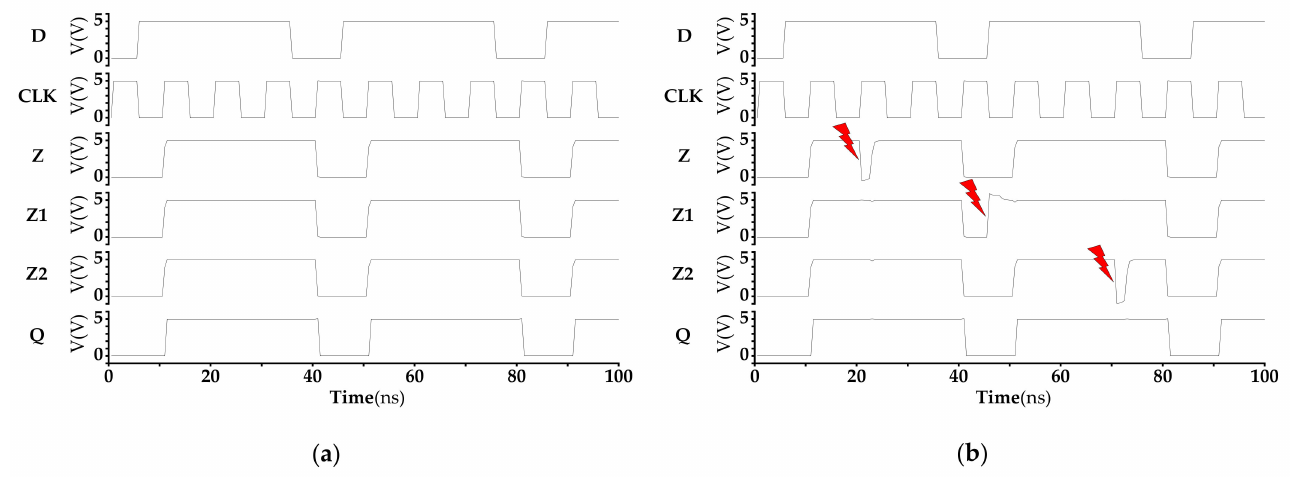
Figure 7. TMR-DFF: ( a ) simulation waveform of TMR-DFF without SETs; ( b ) simulation waveform of TMR-DFF with